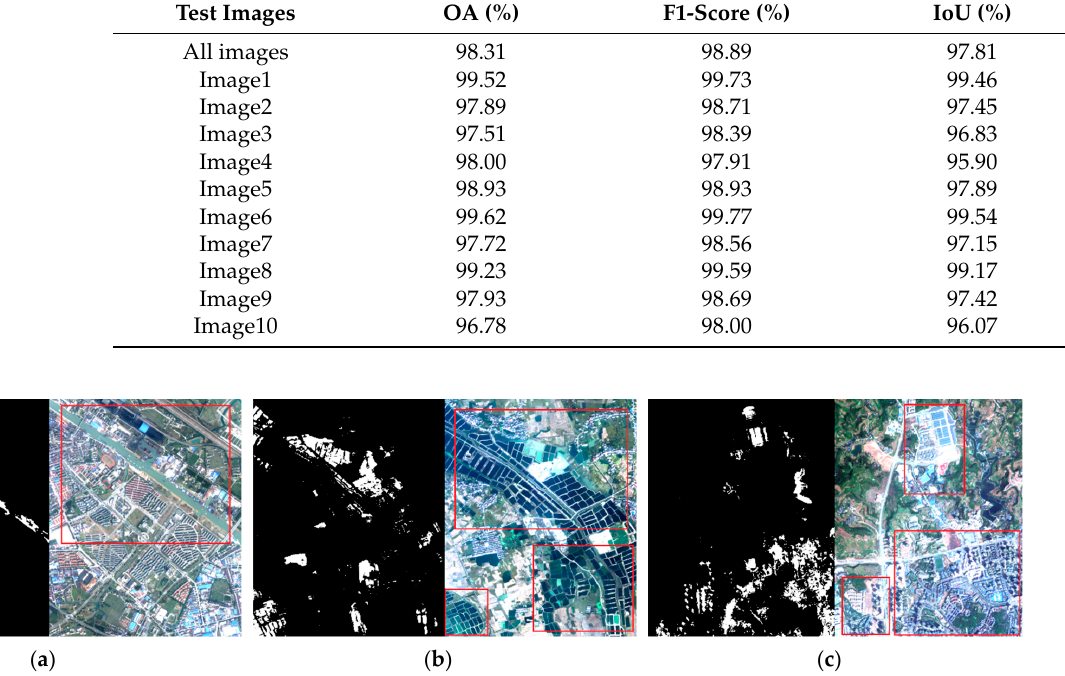
Figure 4. Remote sensing images misclassified by BU-Net: ( a ) Slender rivers that are identified as discontinuous; ( b ) paddy fields that are misclassified as water bodies; and ( c ) industrial and residential land that are misclassified as water bodies. Table 2. Results of OA, F1-score and IoU on the validation images.